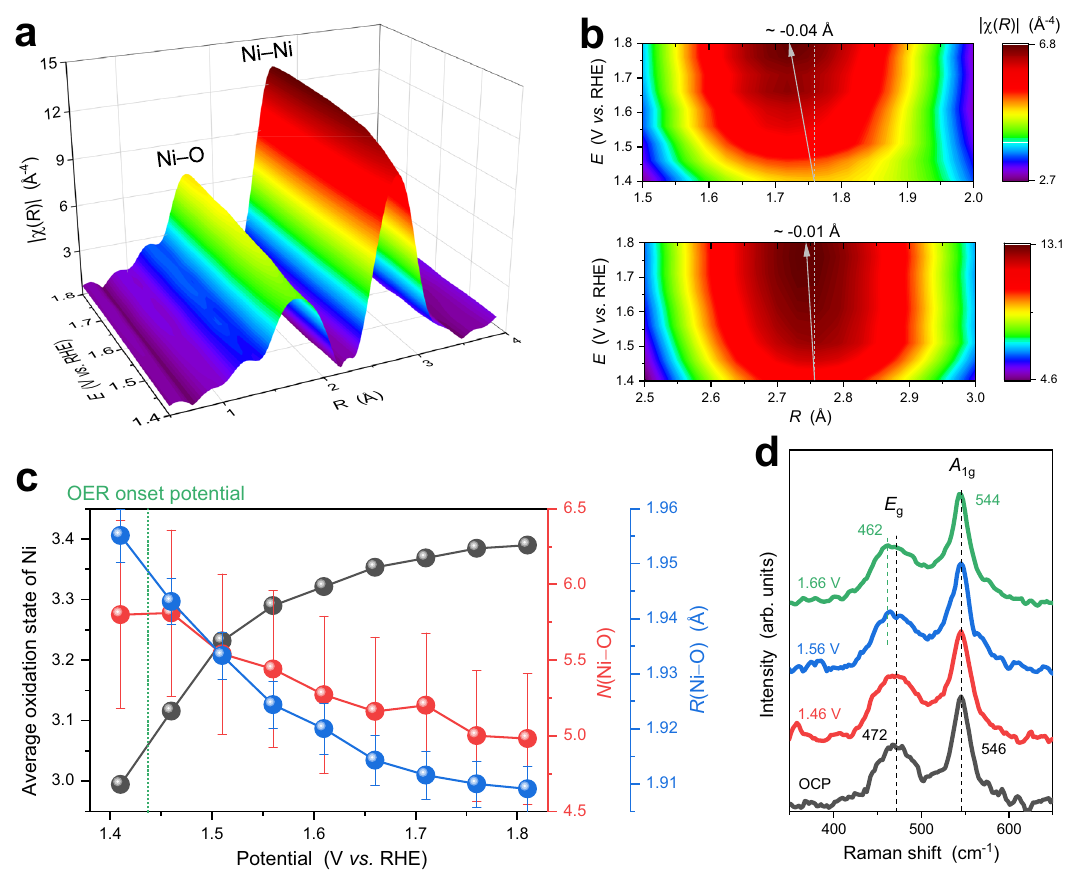
Fig. 6 | Local coordination of LiNiO 2 under OER conditions. a , b Fourier trans- forms of operando Ni K edge EXAFS spectra of LiNiO 2 under applied potentials of 1.41 – 1.81V in 1M KOH solution, with the Ni – O region and the Ni – Ni region mag- ni fi ed to better show the potential-dependent behaviour. The Fourier transfor- mation was carried out over a k range of 2.5 − 12.4Å − 1 , and the Fourier transforms